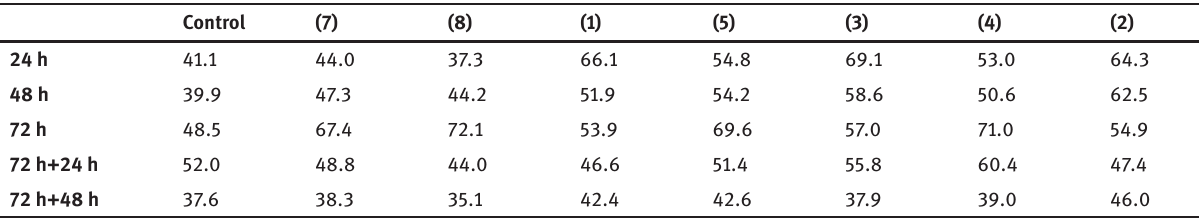
Table 2: The percentage of HL60 cells in G1 phase of cell